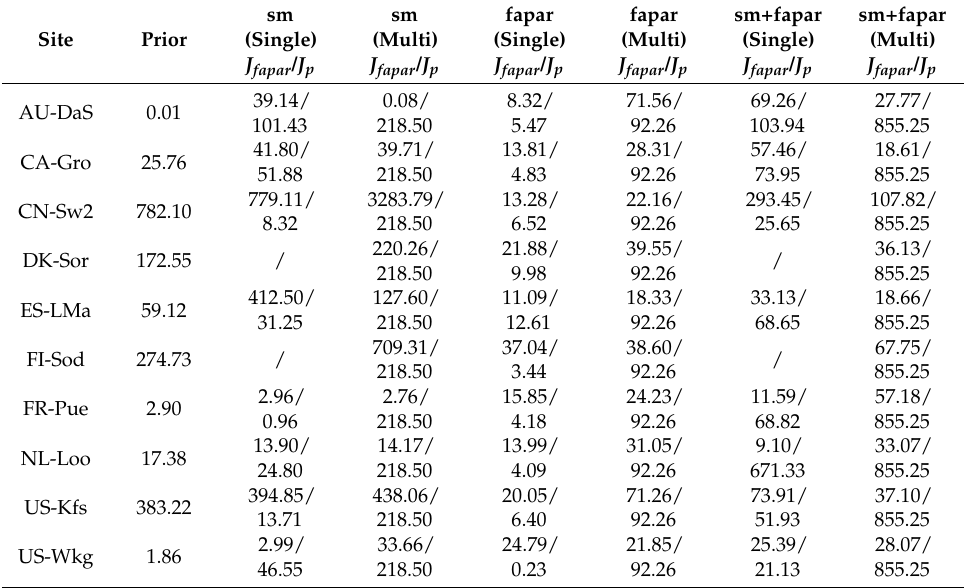
Table 5. Cost function values for FAPAR ( J fapar ) and parameters ( J p ) for prior and different assimilation experiments: ‘Sm’ with soil moisture only, ‘fapar’ with FAPAR only, ‘sm+fapar’ with soil moisture and FAPAR data combined, ‘multi’ denotes multi ‐ site assimilation, and ‘single’ denotes single ‐ site assimilation.